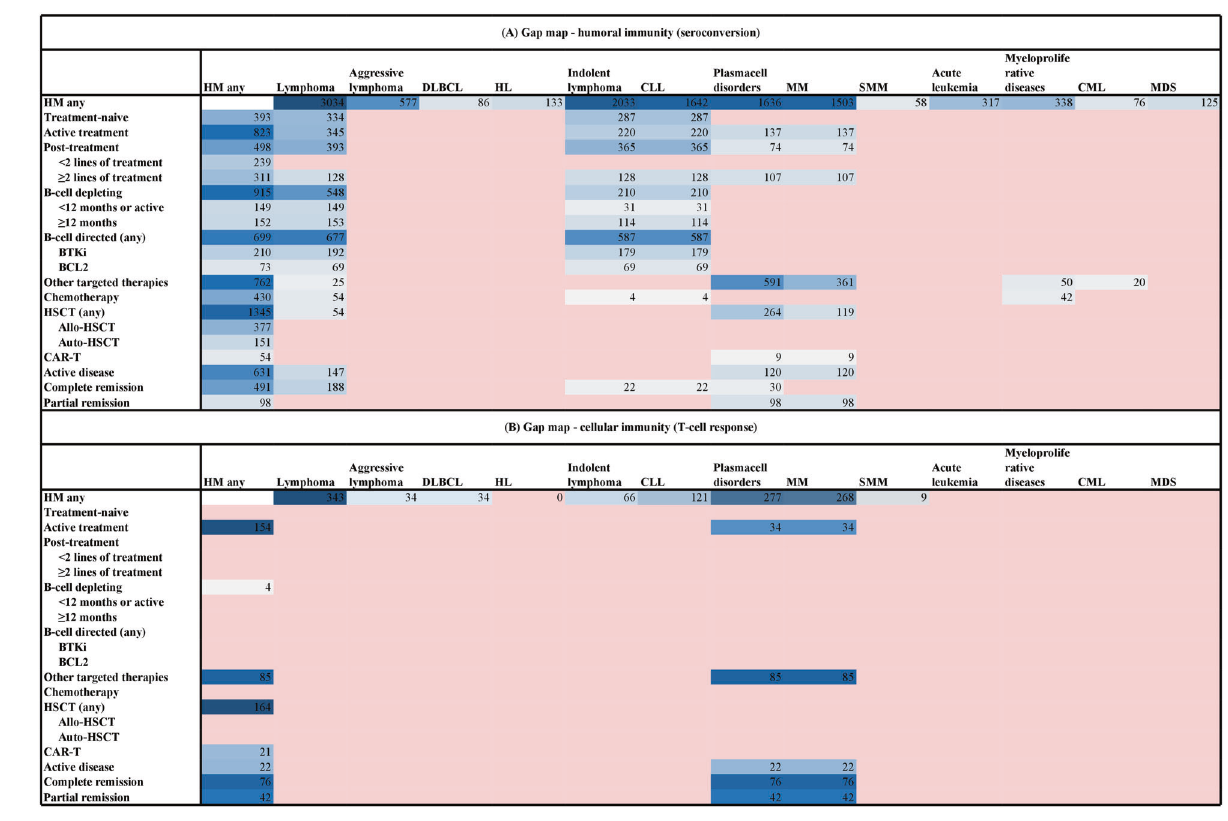
Fig. 3 Evidence-gap maps. A Humoral immunity (seroconversion), B cellular immunity (T-cell